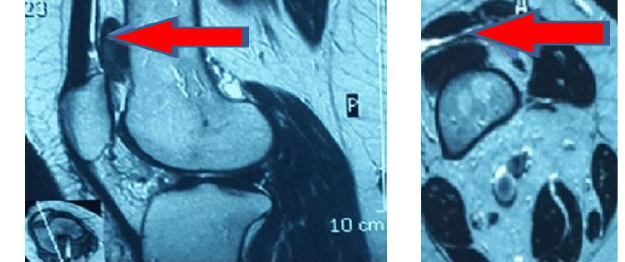
Figure 2: Left knee MRI shown the lesion just above the patella (arrow)sagittal and coronal sections.